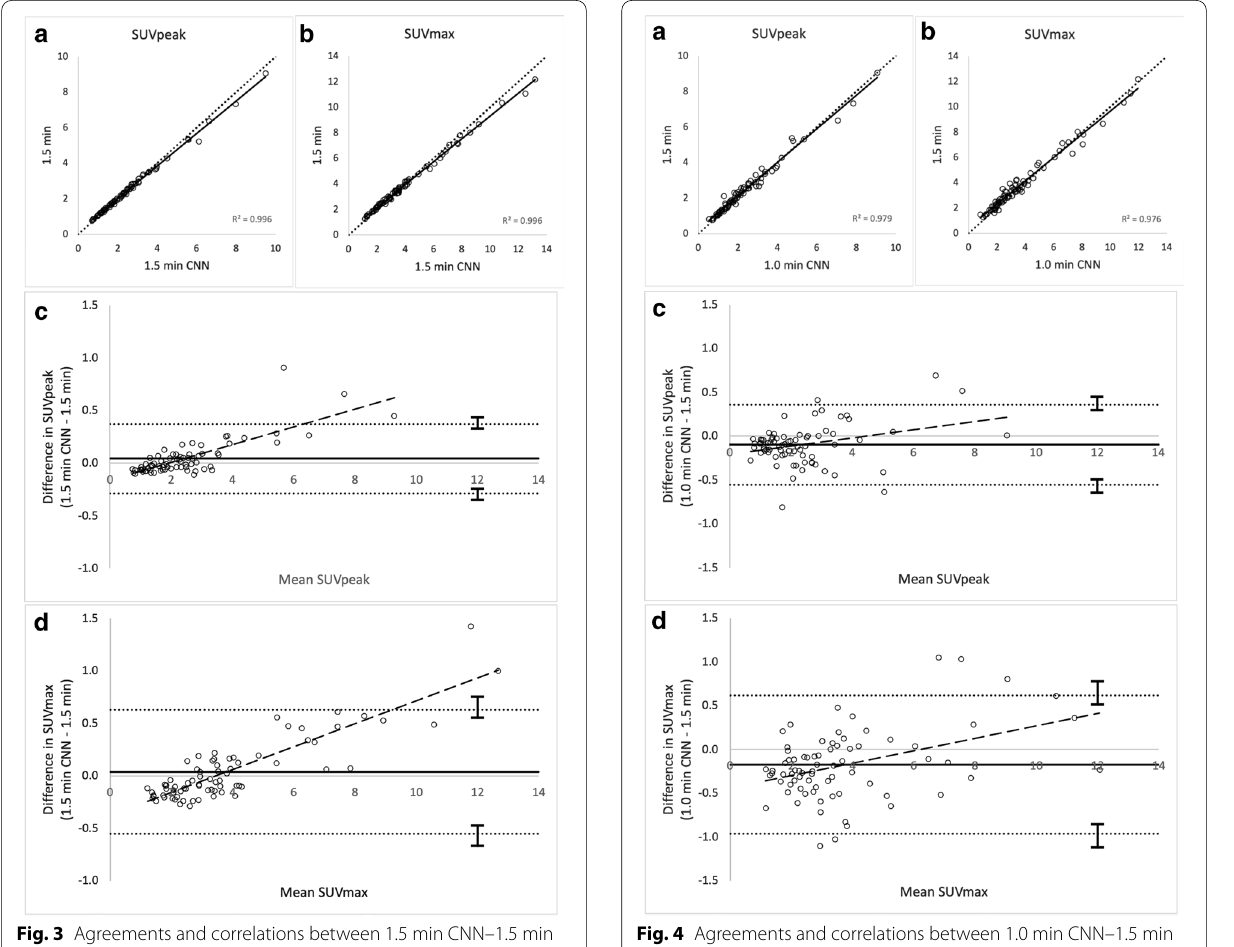
0.10 and 0.18, − − 0.56 and 0.61 −